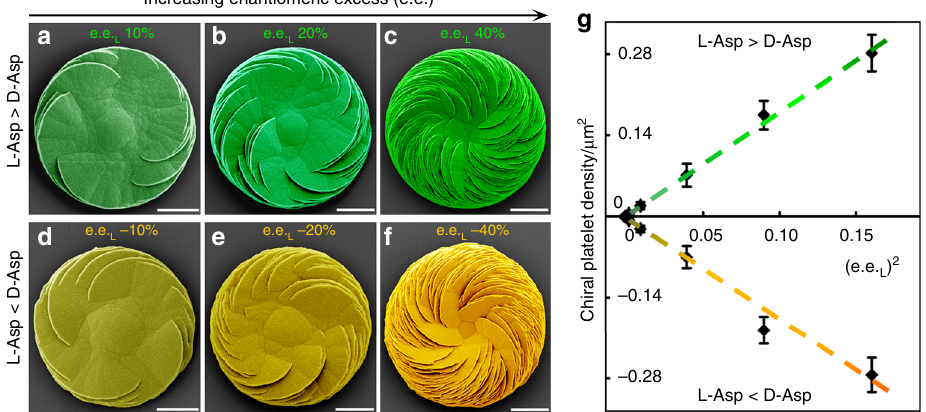
Fig. 3 Relationship between the density of platelets within a chiral vaterite helicoid to enantiomeric excess. a – f Representative SEM images of vaterite helicoids showing chiral vaterite platelets having only counterclockwise or clockwise orientation when either L - or D -Asp is the majority enantiomer under nonracemic solution conditions, respectively. The number of counterclockwise and clockwise platelets increases with increasing enantiomeric excess of L - or D -Asp (green and yellow, pseudocolored, respectively). g Plot showing a linear proportionality relationship between the density of homochiral platelets and the square of enantiomeric excess (e.e. L ) 2 , which indicates a nonlinear increase in oriented platelets with increasing enantiomeric excess (e.e.) as shown in Supplementary Figure 5 ( “ + ” and green colors are arbitrarily assigned to counterclockwise-oriented platelets induced by L -Asp, and “ − ” and yellow colors to clockwise-oriented platelets induced by D -Asp). Error bar represents standard error of mean (Scale bar: 10 μ